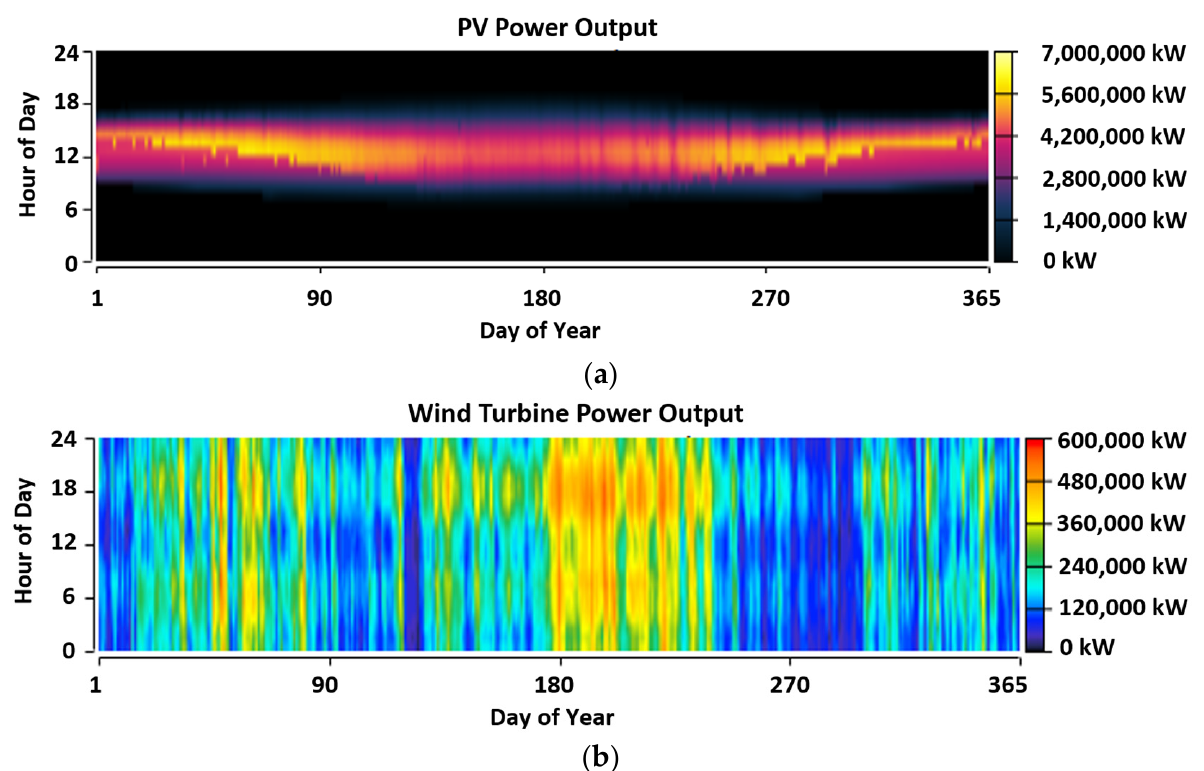
Figure 10. Yearly performance of the energy sources. ( a ) Solar PV; ( b ) wind.